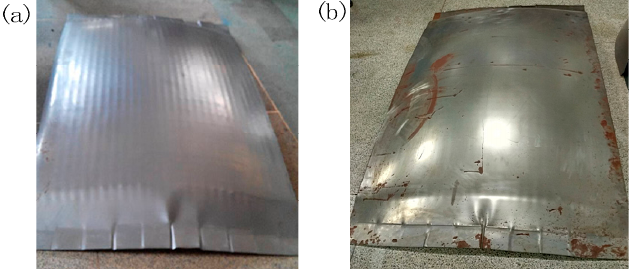
Figure 13. Experimental parts for stretch forming: ( a ) formed by FBHC; ( b ) formed by SBHC.